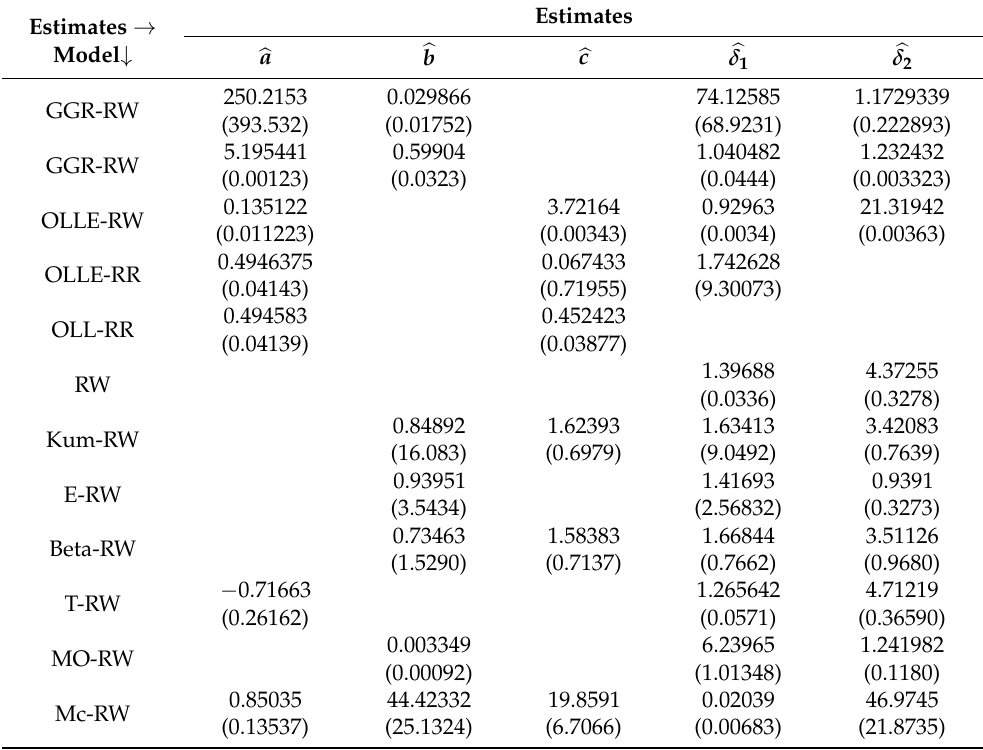
Table 3. MLEs and SEs for the breaking stress of carbon fibers